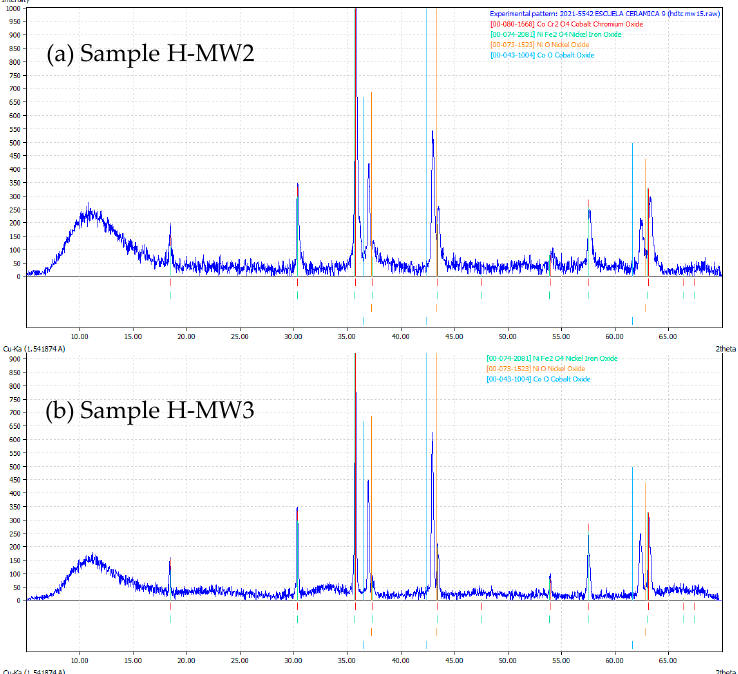
Figure 9. XRD patterns of samples H-MW2 ( a ) and H-MW3 ( b ) (red lines correspond to CoCr 2 O 4 XRD pattern (JCDPS 0801668), light green to NiFe 2 O 4 (JCDPS 0742081), and orange to NiO (JCDPS 0731523)).